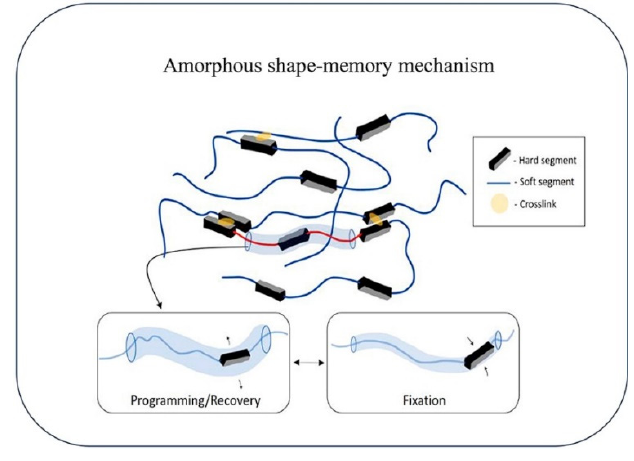
Figure 9. Shape-memory amorphous mechanism [66].